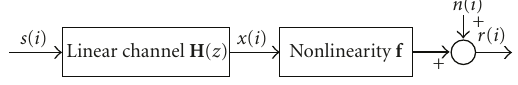
Figure 5: Basic structure of the nonlinear channel.